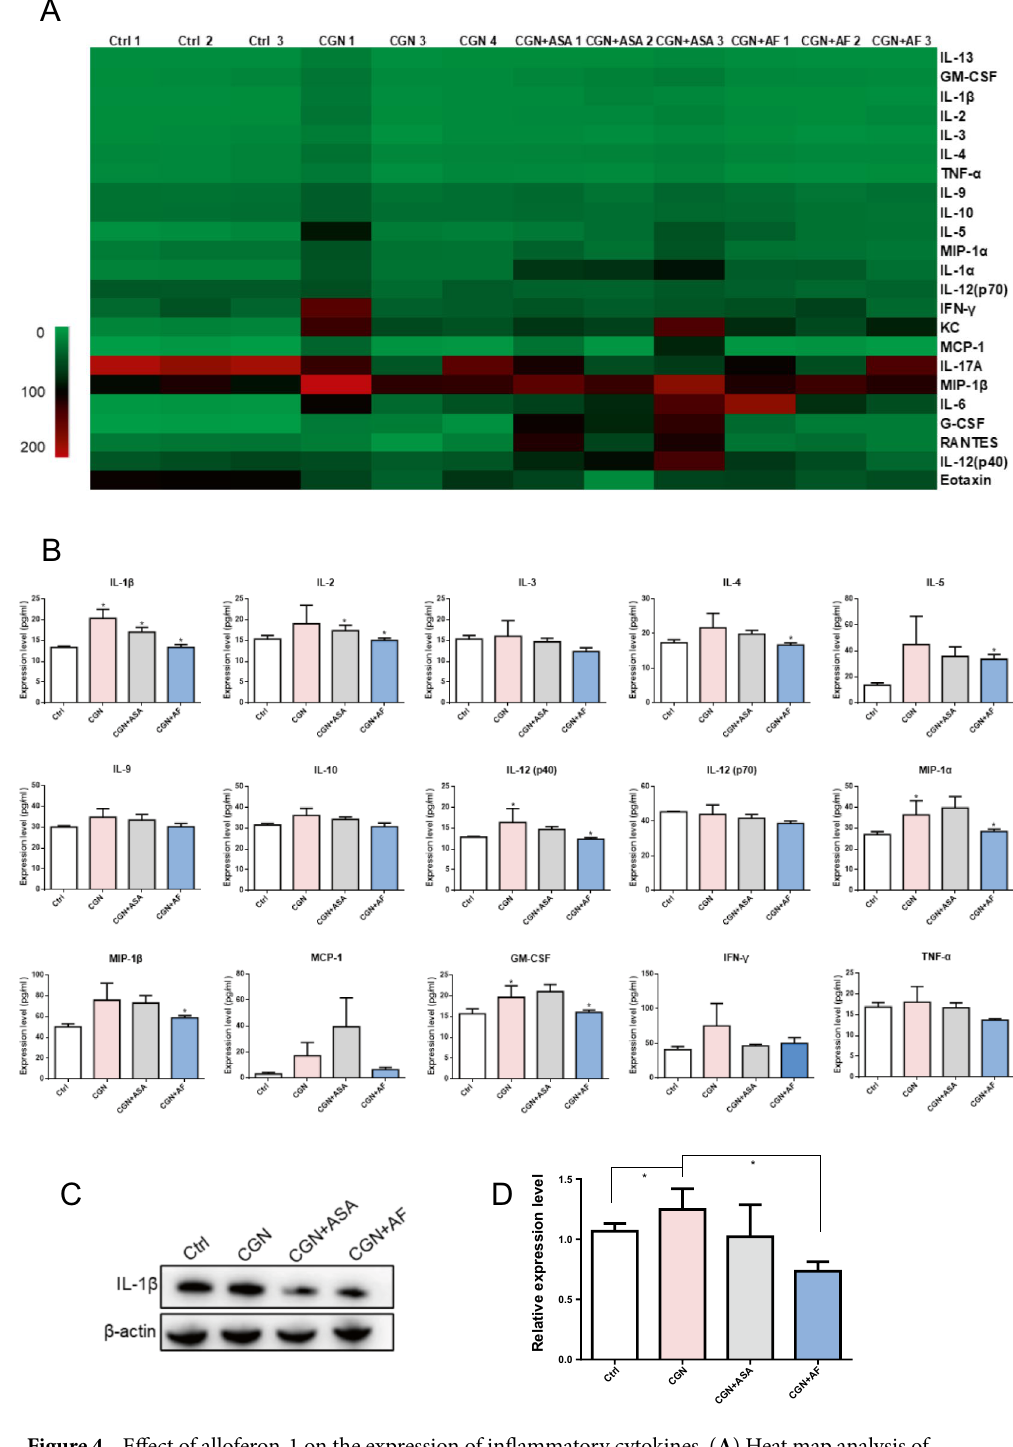
Figure 4. Effect of alloferon-1 on the expression of inflammatory cytokines. ( A ) Heat map analysis of inflammatory cytokines in the serum detected by Luminex liquid cytokine chips (n = 3). The heatmap was generated by Microsoft Excel 2016 (Microsoft Corporation, Redmond, Washington). ( B ) Expression level of cytokines in serum. ( C ) Western blot analysis of IL-1β expression in mice in the serum (n = 3). The original blots are be supplemented in Original images of Fig. 4C. Prior to hybridization with the antibody during blotting, the blotting gel with 12 loading wells was cut into two equal parts. Thus, the full length of the blotting gel was 6 loading wells in total. ( D ) Quantification of the western blot signals with image J. Values are expressed as mean ± SEM. * P < 0.05 were considered as significant difference compared to the control group. Abbreviations: pg/ml, picograms/milliliter; IL, Interleukin; GM-CSF, Granulocyte- macrophage colony stimulating factor; TNF-α, Tumor necrosis factor-α; IFN-interferon-γ; MCP-1, monocyte chemoattractant protein-1; MIP-1, Macrophage inflammatory protein-1; G-CSF, Granulocyte colony stimulating